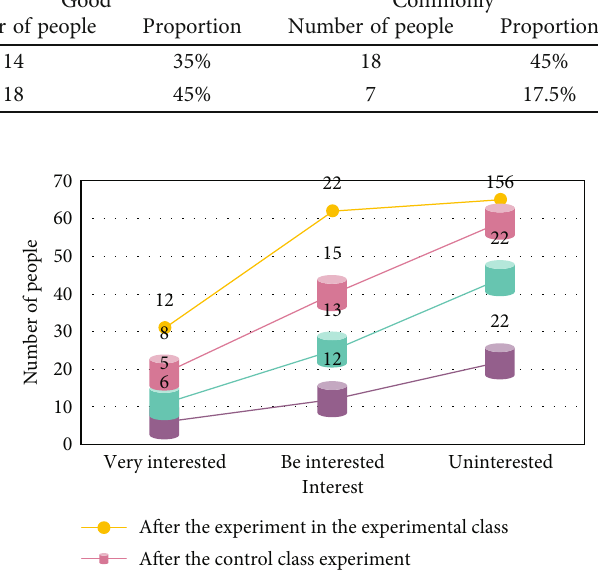
Figure 5: Analysis of the change of interest of two classes.